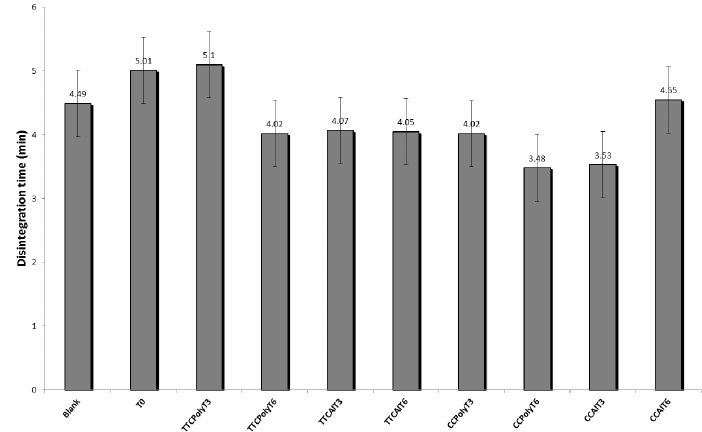
Figure 8. Disintegration time of hydrogel-base formulations. Blank; after production (T0); temperature test chamber-polyethylene-time: 3 months (TTCPolyT3); temperature test chamber-polyethylene-time: 6 months (TTCPolyT6); temperature test chamber-aluminum-time: 3 months (TTCAlT3); temperature test chamber-aluminum-time: 6 months (TTCAlT6); climatic chamber-polyethylene-time: 3 months (CCPolyT3); climatic chamber-polyethylene-time 3months (CCPolyT6); climatic chamber-aluminum-time: 3 months (CCAlT3); climatic chamber-aluminum-time: 6 months (CCAlT6). Results are represented by means ± S.E.M. ( n = 3).